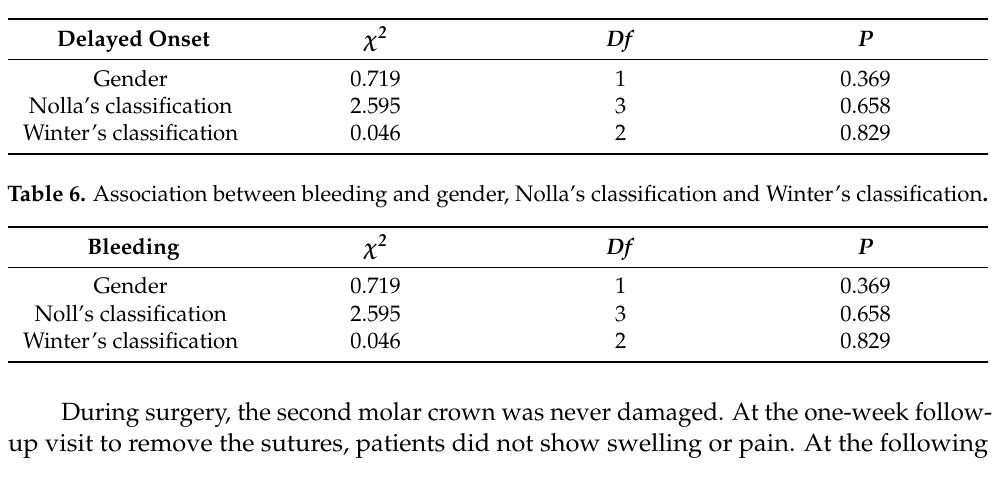
Table 5. Association between delayed onset infection and gender, Nolla’s classification and Win- ter’s classification.